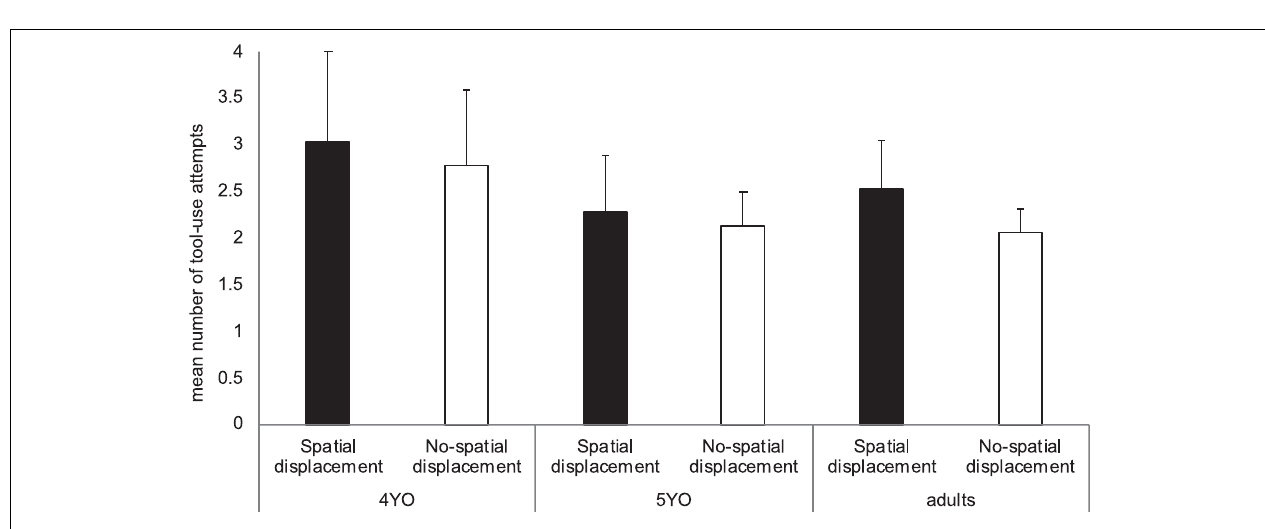
FIGURE 4 | Mean number of tool-use attempts that 4 year-olds (4YO), 5-year-olds (5YO) (Experiment 1) and adults (Experiment 2) needed to obtain the reward grouped by Spatial-displacement condition (black bars) and No-spatial-displacement condition (white bars). Error bars represent the